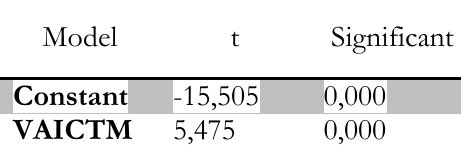
Table 1. Results (t